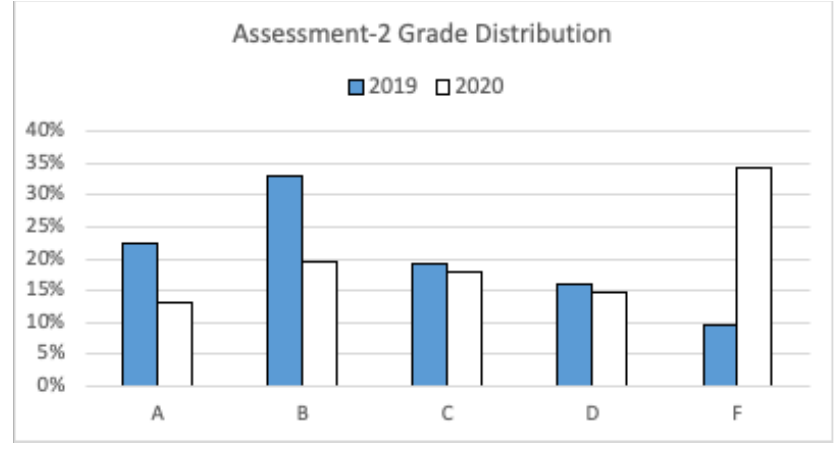
Fig. 2. Grade distribution in Assessment-2 in